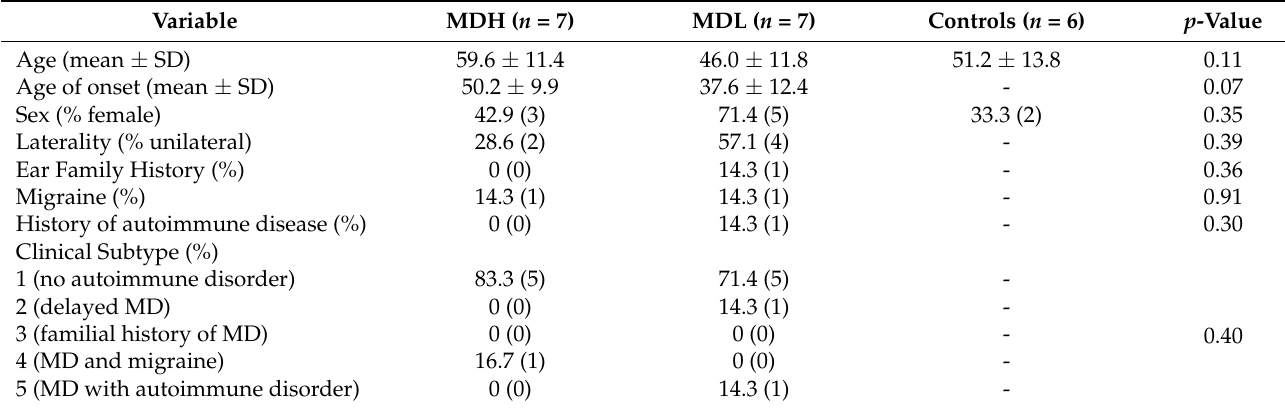
Table 1. Clinical and demographic variables were assessed in patients with Meniere Disease with high levels of IL-1 β (MDH), Meniere Disease with low levels of IL-1 β (MDL) and controls.